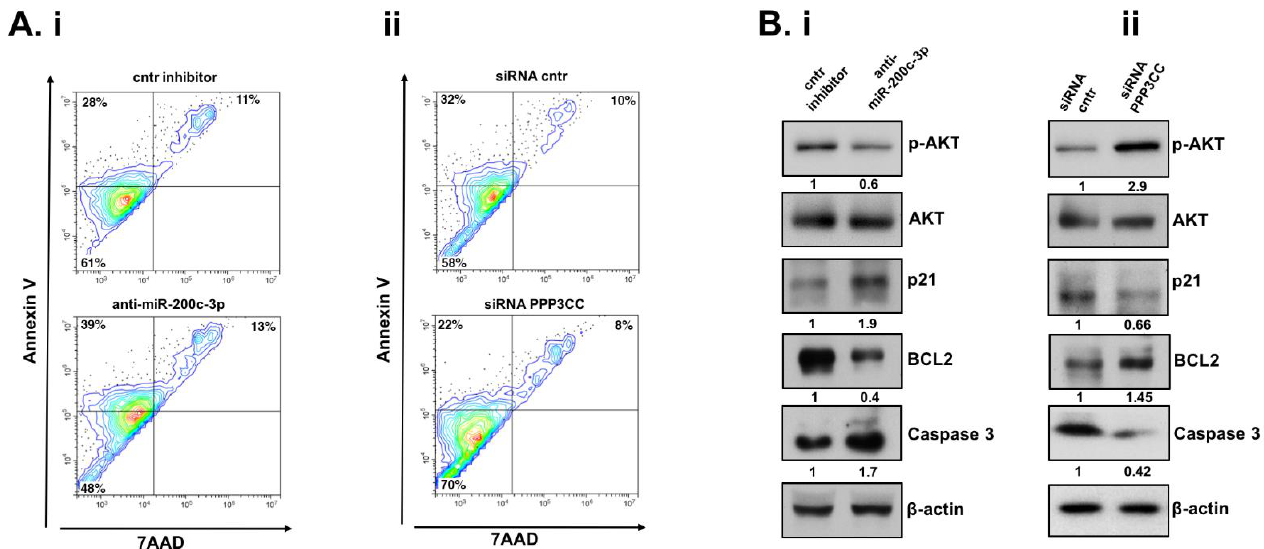
Figure 5. miR-200c-3p inhibition induces apoptosis, whereas reduction of PPP3CC has the opposite effect in EOC transfected cells. ( Ai , ii ): Density plots indicate the percentage (%) of cells in each quadrant distributed as: upper left (UL), early apoptotic cells, Annexin V positive. Upper right (UR), late apoptotic cells, Annexin V/7AAD, double positive and low left (LL), living cells, Annexin V/7AAD negative, at 144 h post-transfection. ( Ai ): cntr inhibitor: UL, 28% and UR 11%. Anti-miR-200c-3p: UL, 39% and UR, 13%. ( Aii ): in siRNA cntr: UL, 32% and UR, 10%. siRNA PPP3CC: UL 22%, and UR, 8%. Data shown are from one representative of at least three different experiments. In the density plots the blue, green, orange and red colors represent the distribution of events comparing Annexin V and 7AAD parameters. A gradual increase in event distribution starts from blue color to red color. ( Bi ): UWB 1.289 + BRCA1 cells were transfected with anti-miR-200c-3p and control inhibitor. At 144 h, WB analysis shows p-AKT and AKT, first and second panel, respectively, followed by p21, BCL-2, cleaved caspase-3, and β-actin. AKT and β-actin were used as loading controls. Values indicate the fold change in each protein obtained through densitometric analysis. Each experiment was performed at least three times. ( Bii ): UWB 1.289 + BRCA1 cells transfected with siRNA, PPP3CC, and siRNA control. At 144 h, WB analysis shows p-AKT and AKT, first and second panel, respectively, followed by p21, BCL-2, cleaved caspase-3, and β -actin. AKT and β -actin were used as loading controls. Values indicate the fold change in each protein obtained through densitometric analysis. Each experiment was performed at least three